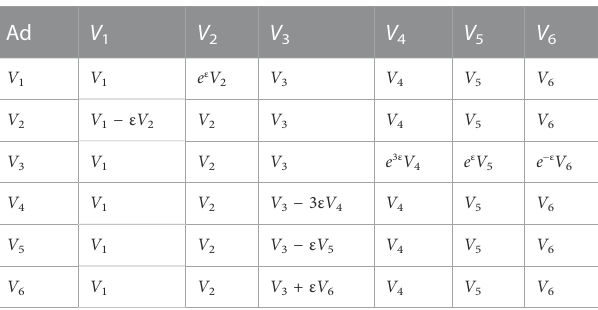
TABLE 2 Adjoint